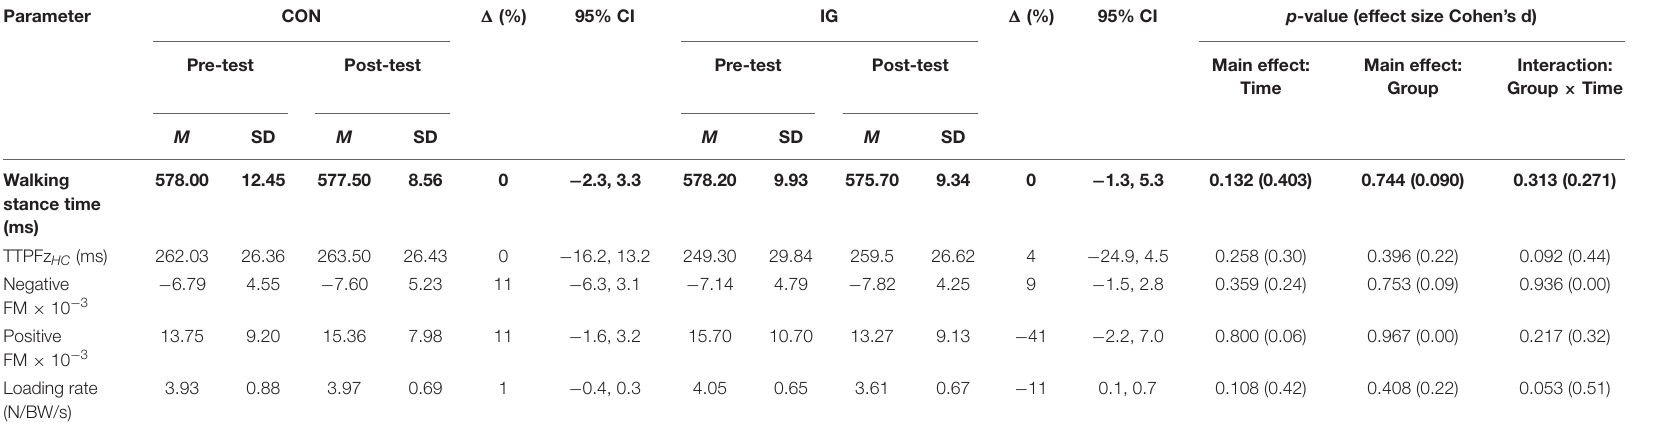
Main effect: Interaction: Time Group Group × Time